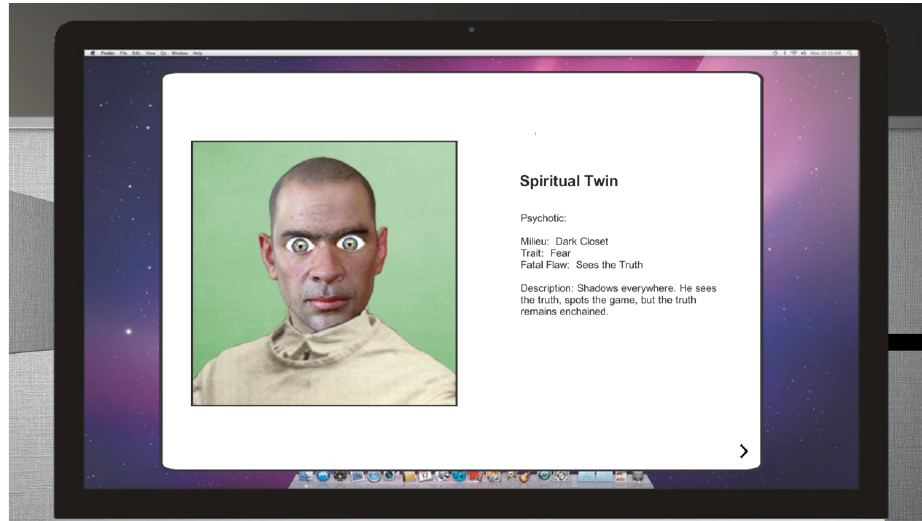
Figure 8. Still from Psychasthenia 3: Dupes . Courtesy of the authors.